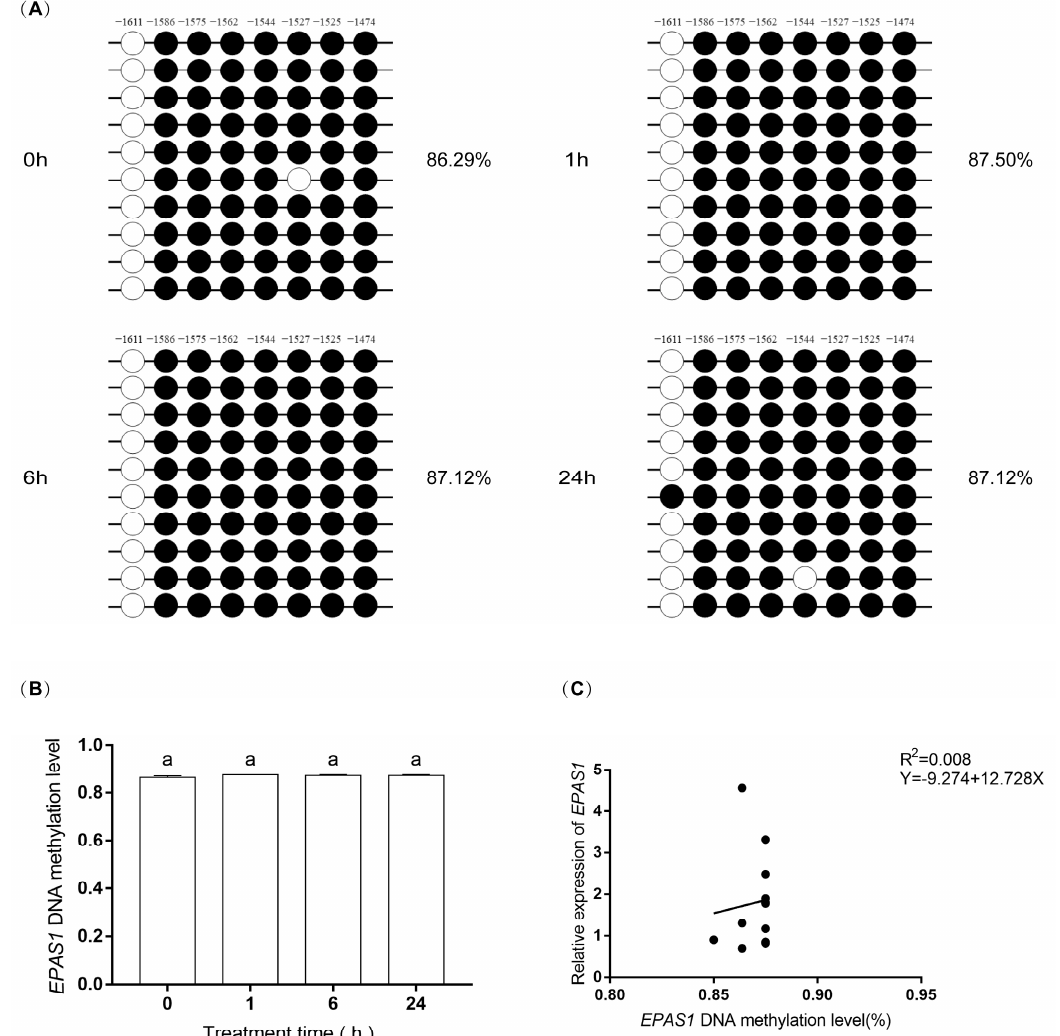
Figure 6. The methylation level of EPAS1 gene promoter at 0 h, 1 h, 6 h, and 24 h after hypoxia. ( A ) The methylation status and levels of EPAS1 gene. The circles show the methylation status. The numbers above the circles represent 8 CpG dinucleotides. The percentage on the right of the circles is the average methylation level of the corresponding group. ( B ) The methylated levels of EPAS1 gene. The three biological replicates methylation levels in the 1 h group were consistent, so there was no visible SE. ( C ) Linear regression analysis of methylation levels and mRNA relative expression levels of